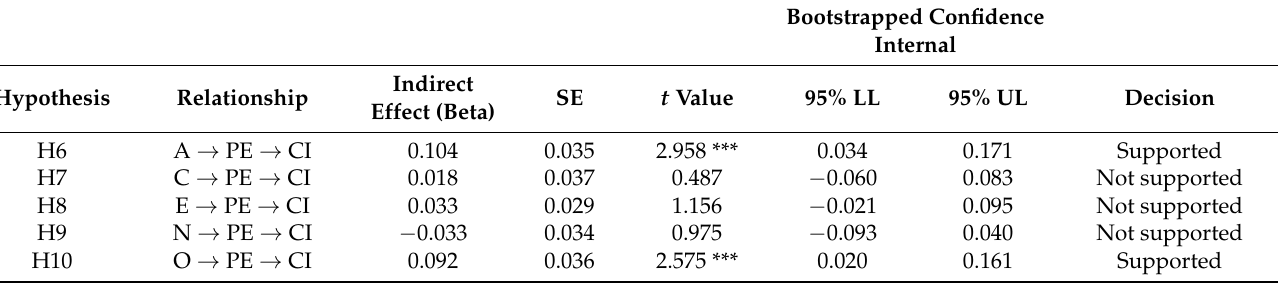
Table 6. Summary of Mediation Results.